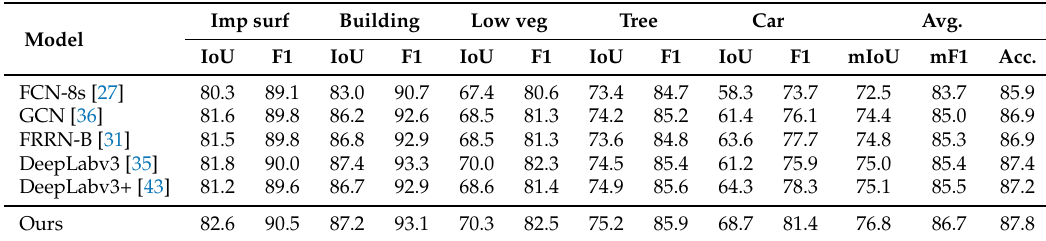
Figure 7. Precision-recall (PR) curves of all the comparing deep learning models on Vaihingen local evaluation. Categories from left to right: impervious surface (imp surf), building, low vegetation (low veg), tree, car. Table 1. Local evaluation results on ISPRS Vaihingen dataset. Imp surf: impevious surfaces. Low veg: low vegetation. MIoU: average of five objects’ IoUs. MF1: acerage of five obejects’ F1 scores. Acc.: overall accuracy.